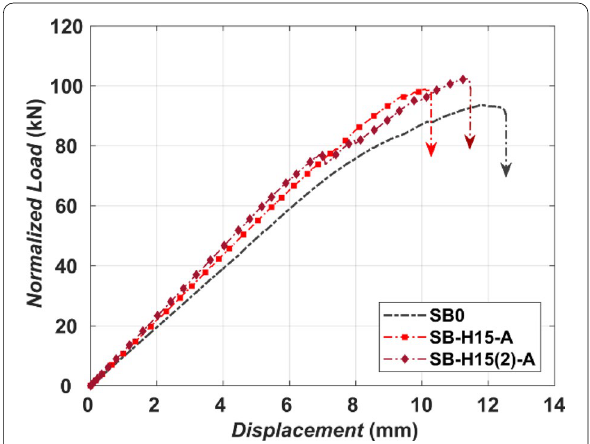
Fig. 12 Load–deflection curves for specimens SB‑H15‑A and